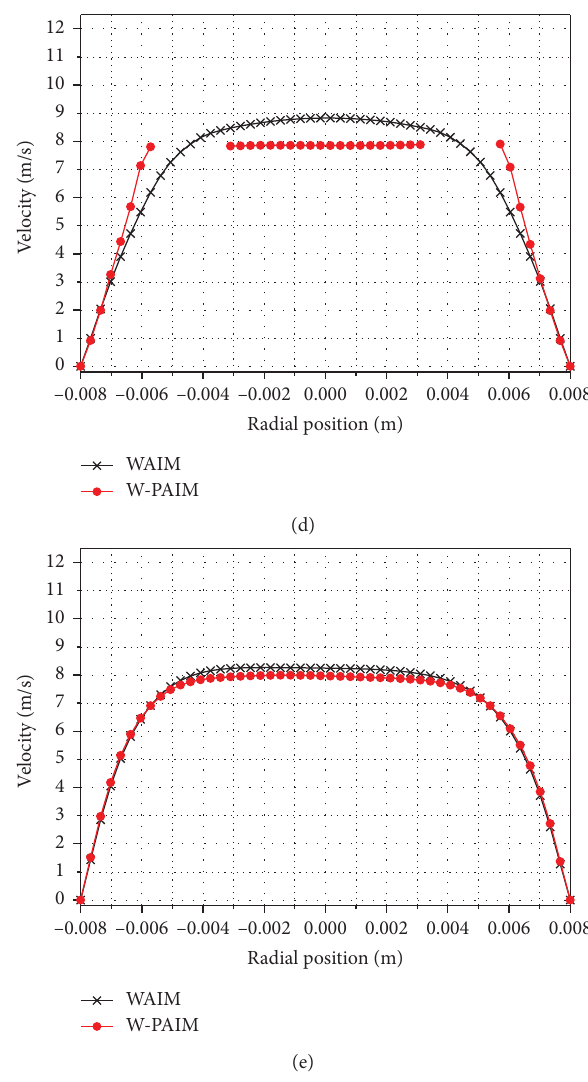
Figure 6: Comparison of the velocity distribution near the penetration front at the middle location of straight segments between WAIM and W-PAIM: (a) velocity magnitude contour of WAIM, (b) velocity magnitude contour of W-PAIM, (c) velocity profiles at position I, (d) velocity profiles at position II, (e) velocity profiles at position III (I denotes the location of 0.04mm, II is 0.05 mm, and III is 0.06